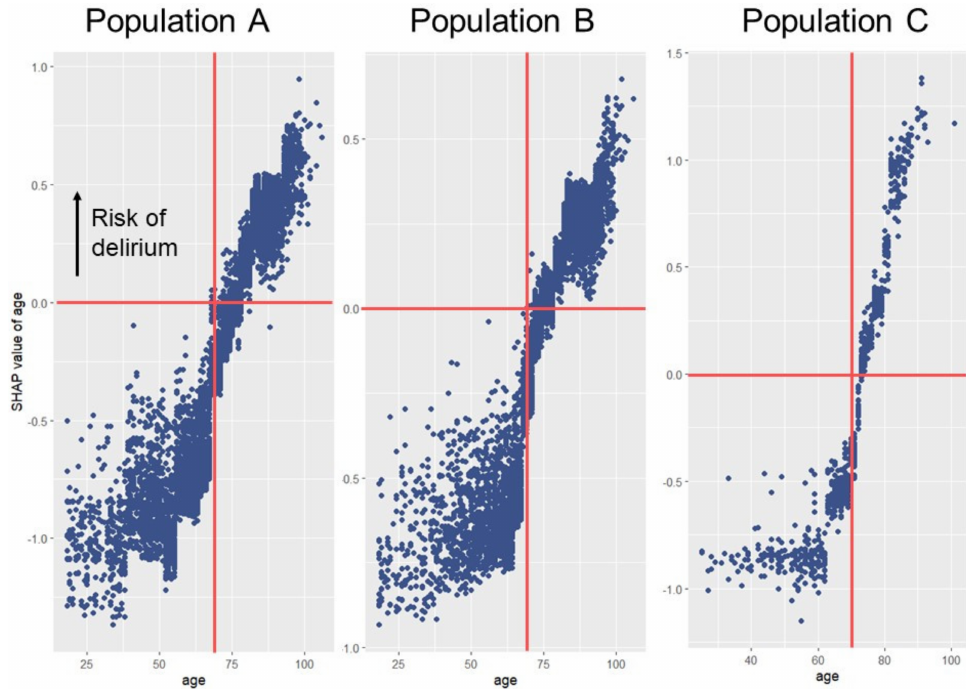
Figure 7. SHAP dependence plot for age. Each dot denotes a patient. The x-axis is the age of patients, and the y-axis shows the SHAP values attributed to the age. Higher SHAP values represent higher risk of delirium due to age.